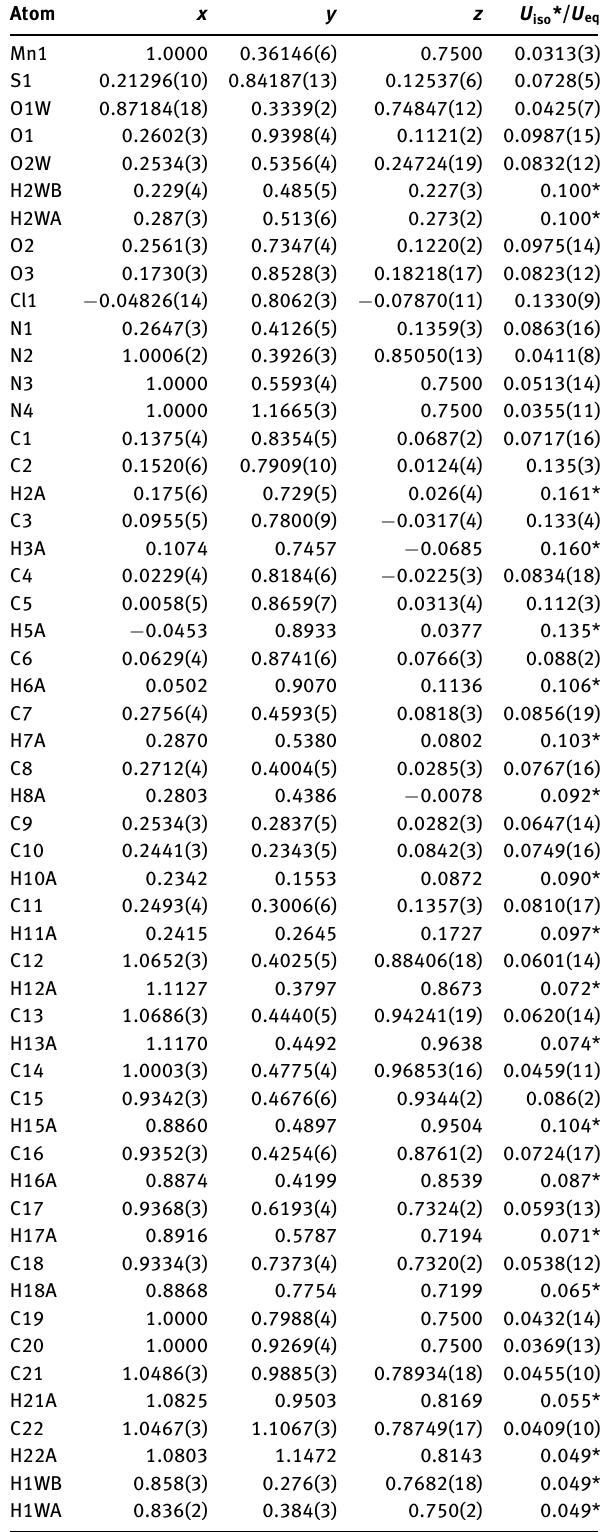
Table 2: Fractional atomic coordinates and isotropic or equivalent isotropic displacement parameters (Å 2